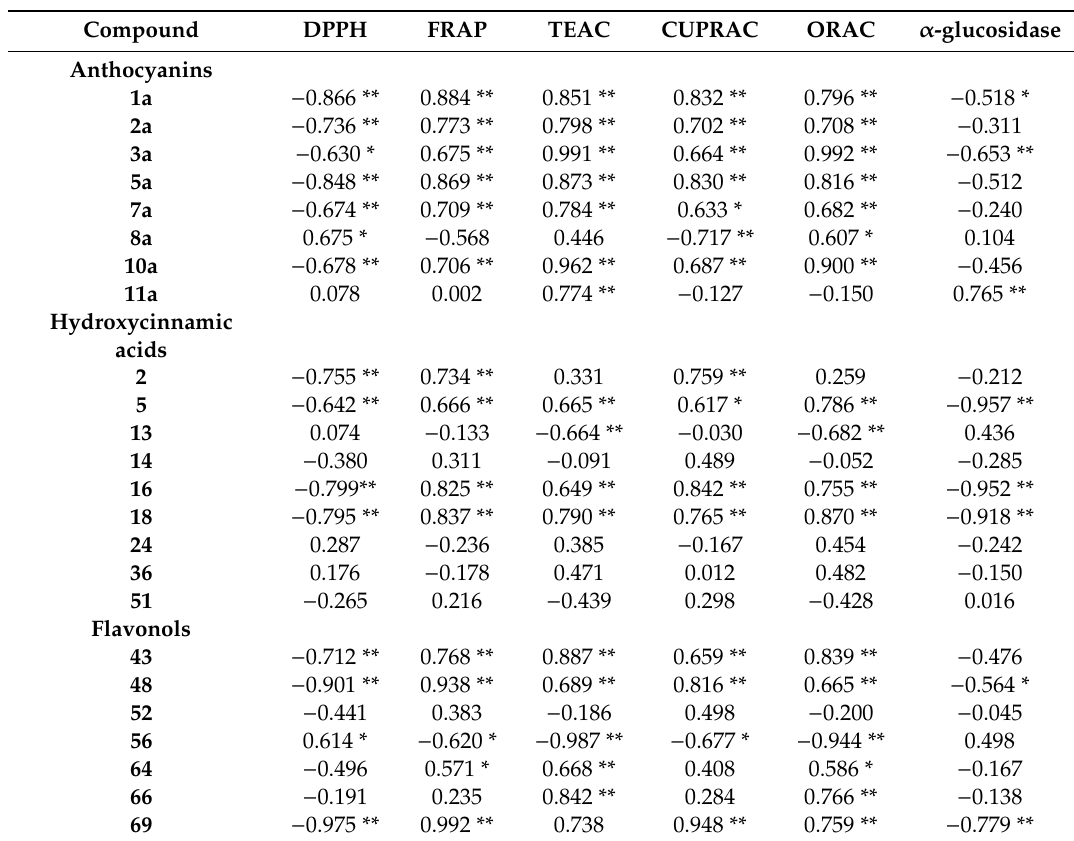
Table 6. Pearson’s correlation coe ffi cient for the content of polyphenols, antioxidant activity, and α -glucosidase